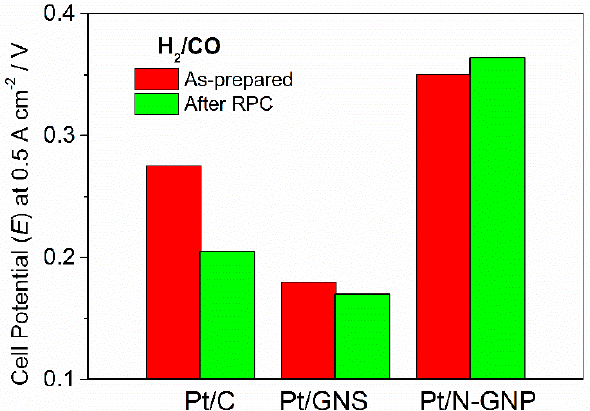
Figure 7. Cell potential at 0.5 A cm − 2 with Pt/C, Pt/GNS, and Pt/N-GNP as anode materials fed with H 2